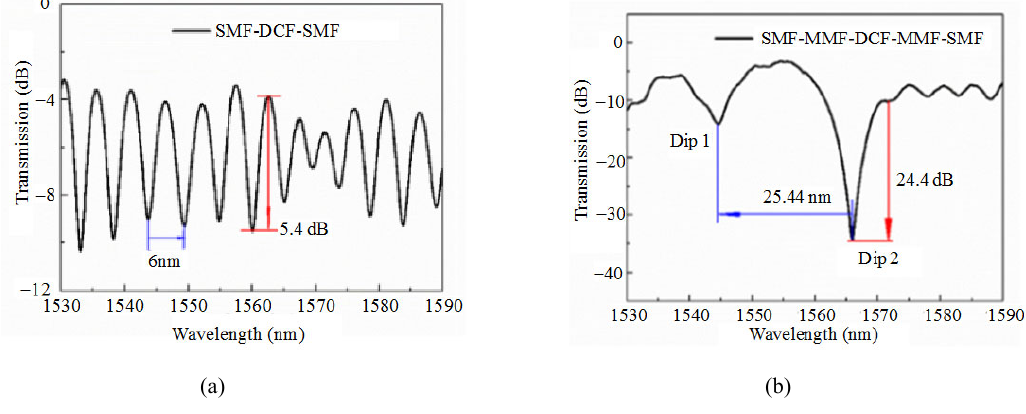
Fig. 5 Interference spectra for two different MZI structures: (a) SMF-DCF-MMF and (b) SMF-MMF-DCF-MMF-SMF.